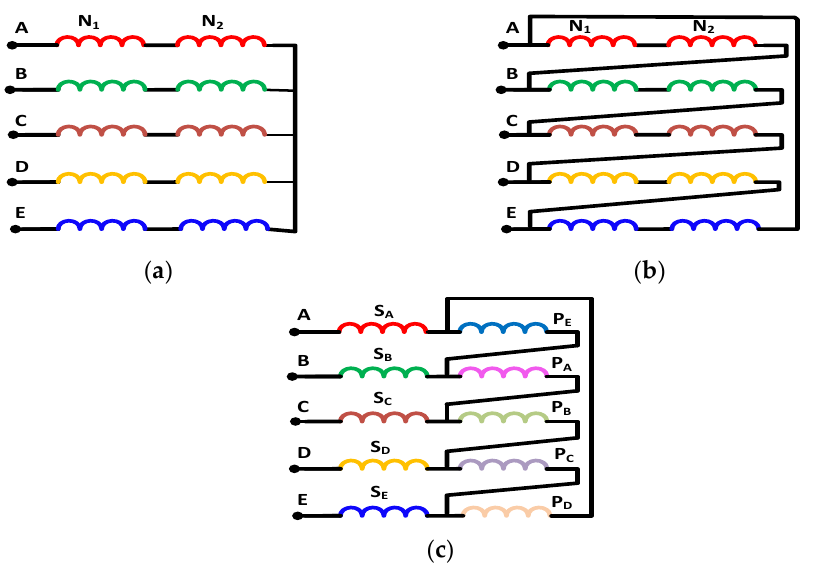
Figure 5. ( a ) Star connection N 1 = N 2 = 24, ( b ) pentagon connection N 1 = N 2 = 29, and ( c ) combined star – pentagon connection N 1 = 24, N 2 = 29.